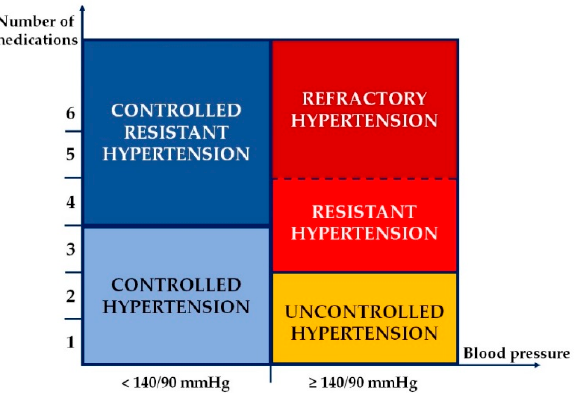
Figure 1. Hypertension classification based on blood pressure control and number of antihypertensive medications.